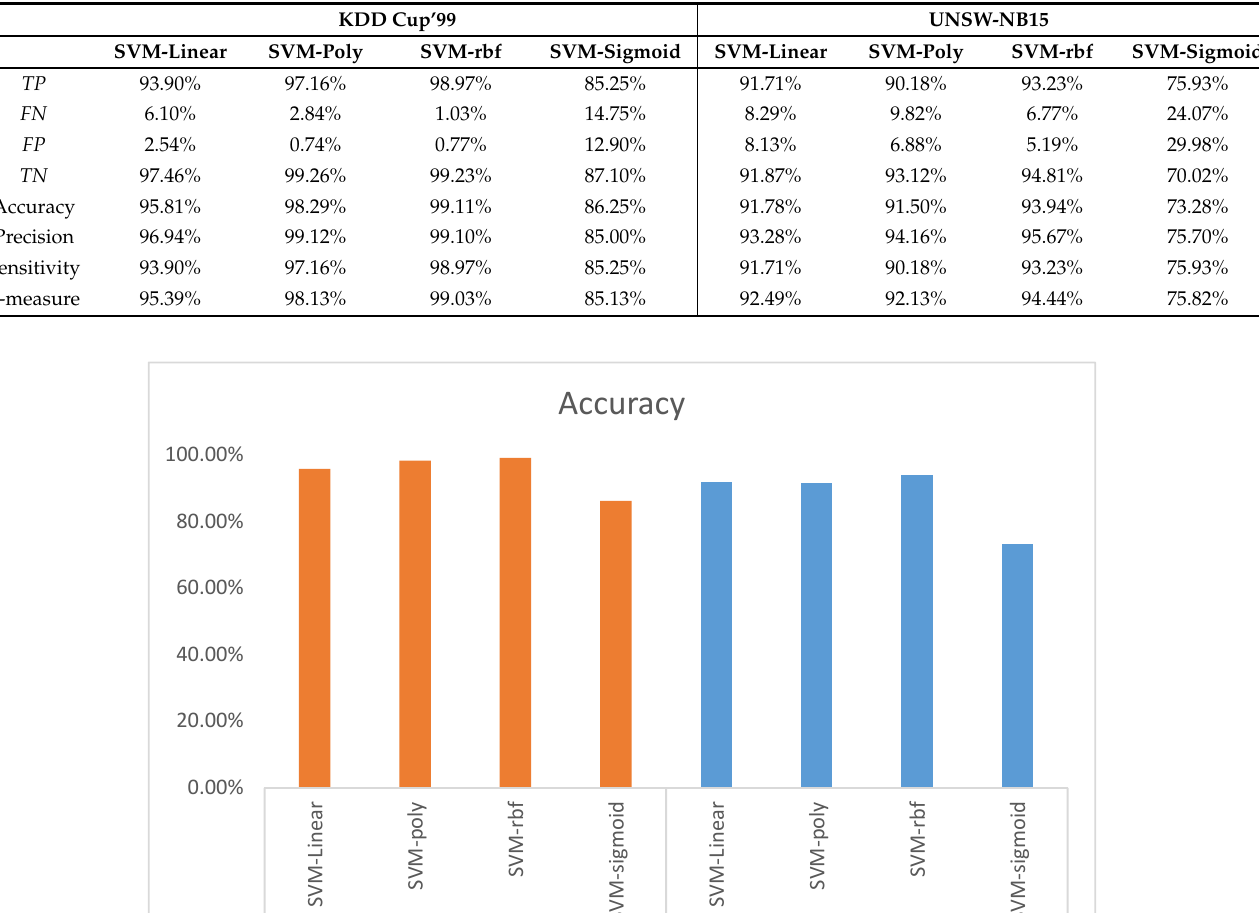
datasets. The precision for SVM-linear, SVM-ploy, SVM-RBF, and SVM-sigmoid using the KDD CUP’99 dataset is 96.94%, 99.12%, 99.10%, and 85.00%, respectively. Meanwhile, the precision for SVM-linear, SVM-ploy, SVM-RBF, and SVM-sigmoid using the UNSW- NB15 dataset is 93.28%, 94.16%, 95.67%, and 75.70%, respectively. The obtained data show that the SVM-ploy kernel function outperformed other kernel functions for KDD CUP’99 datasets in terms of precision with a very simple superiority of the SVM-RBF function. Concerning the UNSW-NB15 dataset, the SVM-RBF kernel function outperformed other kernel